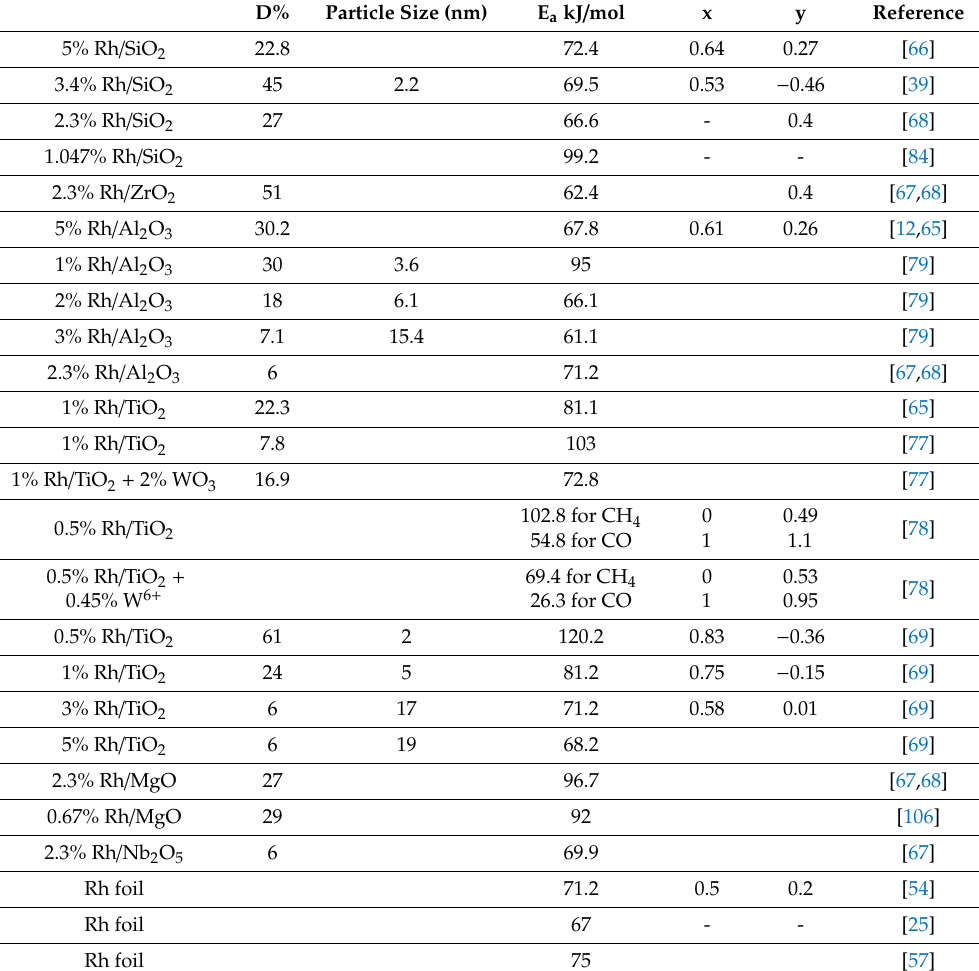
Table 1. Comparison of the kinetic data for CO 2 + H 2 reaction obtained on di ff erent Rh